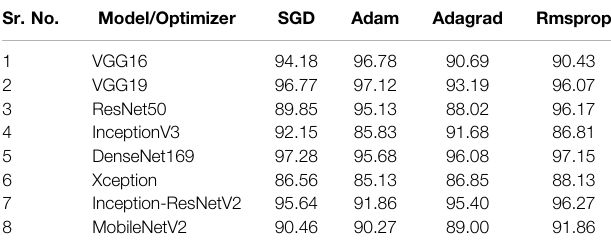
TABLE 8 | Performance evaluation based on testing accuracies for multi-class classi fi cation [Accuracy (%)]. Sr. No.